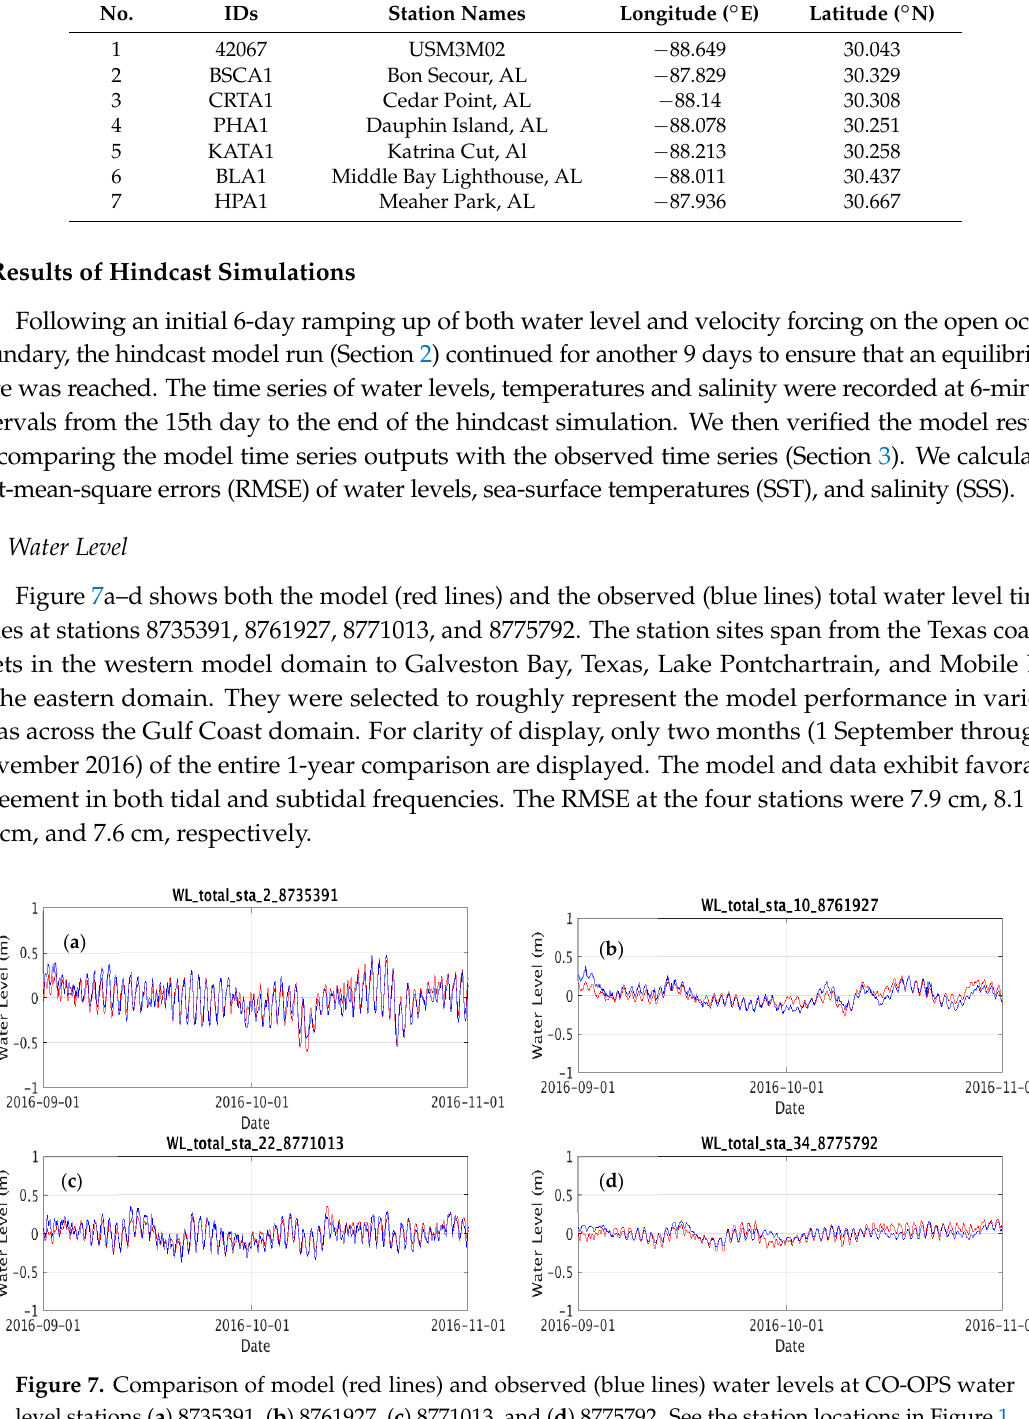
Figure 8. Comparison of model (red lines) and observed (blue lines) water levels at CO-OPS water level stations ( a ) 8735391, ( b ) 8761927, ( c ) 8771013, and ( d ) 8775792. See the station locations in Figure 1. Figure 9a,b illustrates the RMSE maps of the total and subtidal model water levels at 55 CO-OPS water level stations (Table A1). In general, RMSE is evenly distributed across the model domain, except for stations 8760721 and 8761955 along the lower Mississippi River. Comparing the model- data water level time series in addition to the Mississippi River discharge measured at USGS station 07374000 (Baton Rouge, LA) (Table 2), it has been identified that the larger RMSE can be attributed to the water level setup from a large river discharge event which occurred between May and June of 2017. The river discharge during this period reached a magnitude as large as about 36,400 m 3 /s as compared with an average value of about one-third of that value during the remaining time of the hindcast period. Not including the two Mississippi River stations, the average total water level RMSE equals about 8.6 cm with a standard deviation (SD) of 1.8 cm, and the average subtidal RMSE equals about 7.4 cm with a SD of 1.7 cm.